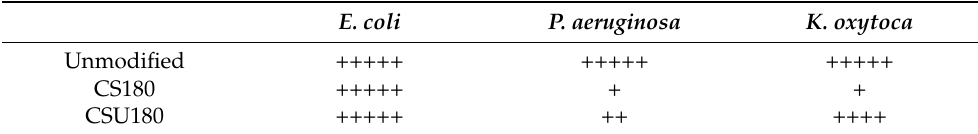
Table 5. Microbial enumeration.